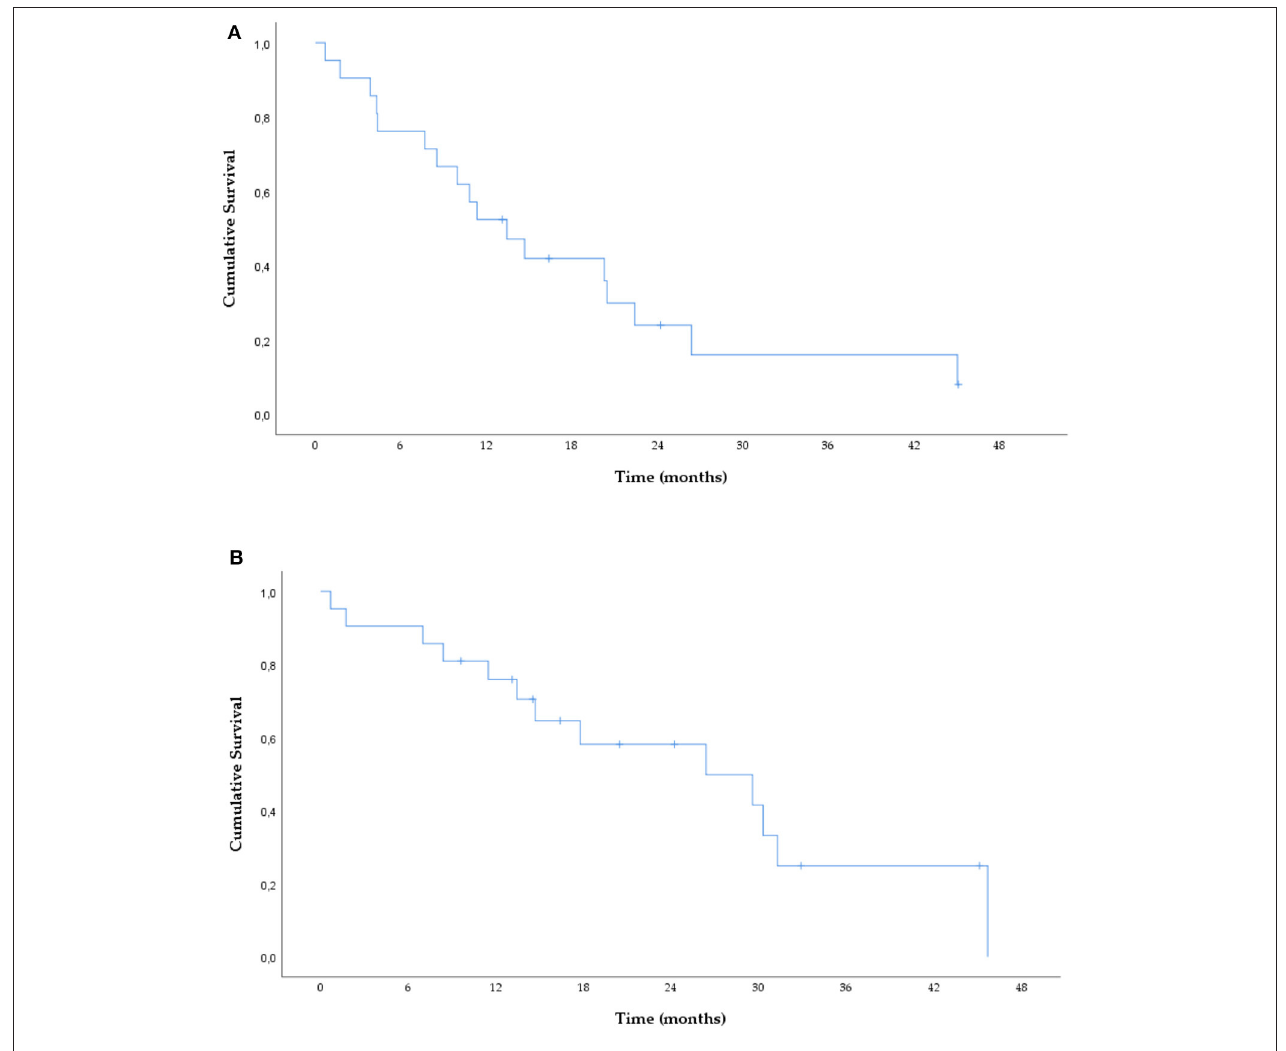
FIGURE 1 | PFS (A) and OS (B) under osimertinib treatment.